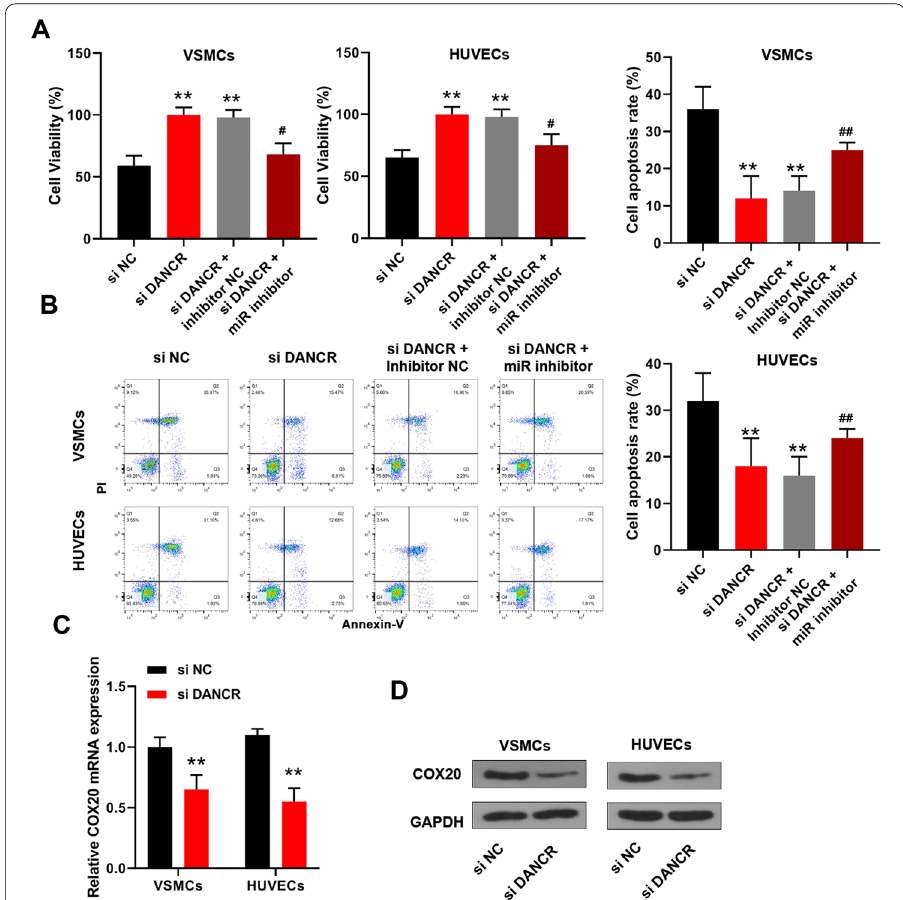
Fig. 5 MiR-214-5p downregulation obviously attenuated si-DANCR-induced protection against ox-LDL-induced endothelial injury. A , B VSMCs and HUVECs were transfected with si-DANCR, si-NC, or co-transfected with si-DANCR and inhibitor NC, or co-transfected with si-DANCR and miR-214-5p inhibitor, and then cells were treated with 50 μg/ml ox-LDL for 48 h. A CCK-8 assay. B Flow cytometry assay. C , D VSMCs and HUVECs were transfected with si-DANCR or si-NC, and then treated with 50 μg/ml ox-LDL for 48 h. COX20 expression was evaluated by qRT-PCR ( C ) and Western blot ( D ). The original images are shown in Additional file 1. Each experiment was repeated three independent times. **p < 0.01 vs. si-NC; ## p < 0.01 vs. si-DANCR plus inhibitor NC